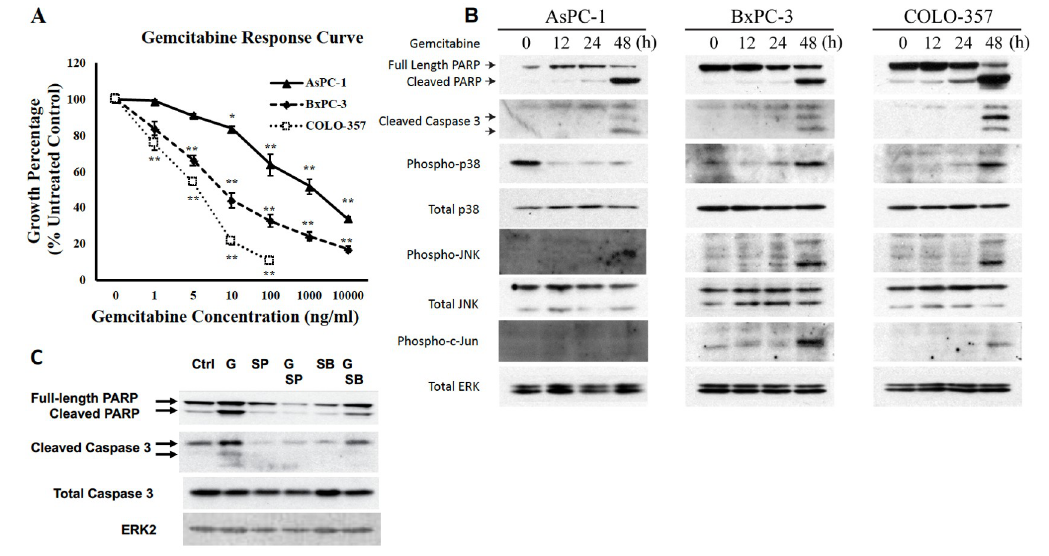
Fig 1. Effects of gemcitabine on human pancreatic cancer cells. (A) AsPC-1, BxPC-3, and COLO-357 cells were incubated for 48 h in the absence or presence of varying concentrations of gemcitabine, and MTT assays were performed. Data are the means ± SEM of 3 experiments. � p < 0.05; �� p < 0.01, compared with control. (B) AsPC-1, BxPC-3, and COLO-357 cells were incubated for the indicated times with 100 ng/ml, 10 ng/ml, and 5 ng/ml gemcitabine, respectively, and analyzed by immunoblotting. All blots shown in panel B are from a single representative experiment for each cell line. (C) BxPC-3 cells were incubated for 48 h with 10 ng/ml gemcitabine (G), in the absence or presence of 10 μ M SB203580 (SB) or 10 μ M SP600125 (SP), and analyzed by